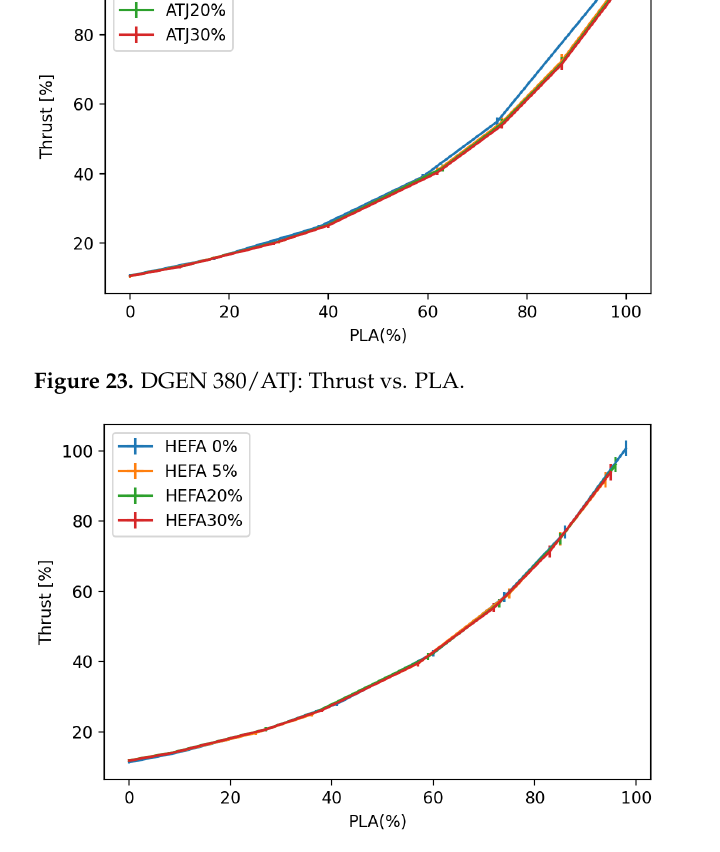
Figure 24. DGEN 380/HEFA: Thrust vs. PLA.